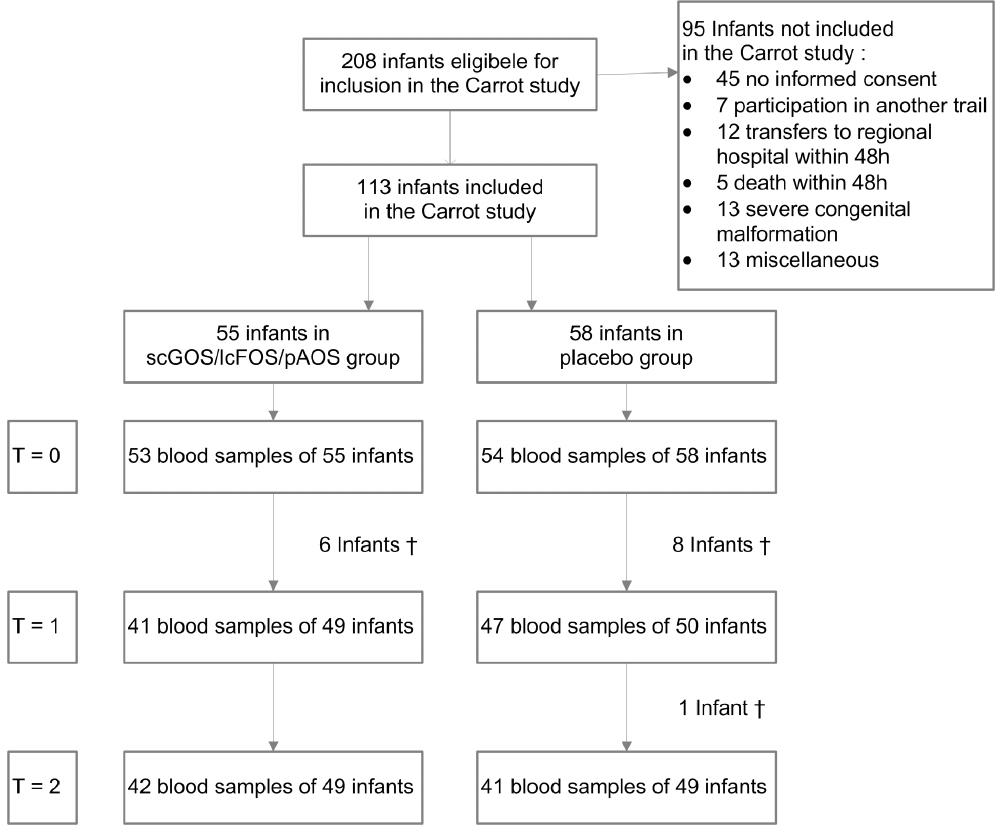
Figure 1. Trial profile. { died.